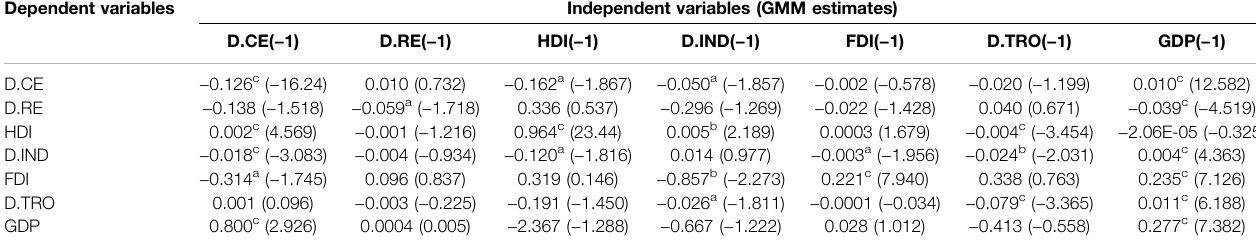
TABLE 8 | Panel VAR model estimation results for high-income countries. Dependent variables